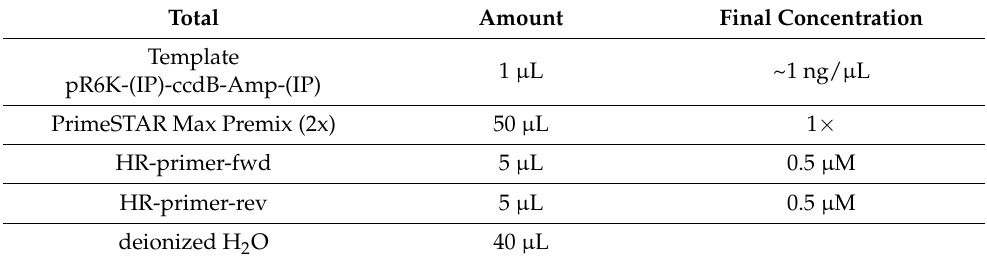
Table 3. Composition of PrimeSTAR DNA polymerase PCR reaction mixture.